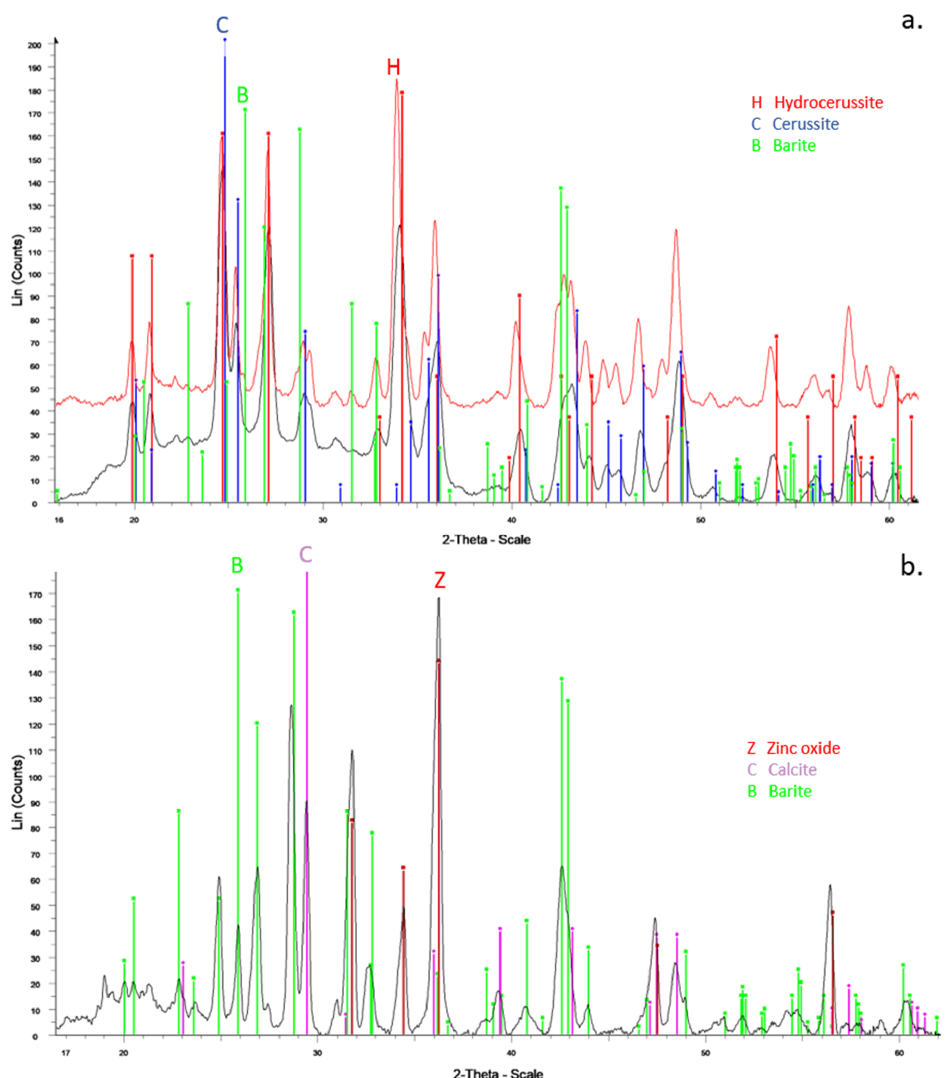
Figure 8. ( a ). XRD diagram shows the presence of hidrocerussite (red vertical lines), cerussite (blue vertical lines) and barite (green vertical lines) in CRIST07 (black spectra) and CRIST08 (red spectra) zones. ( b ). XRD diagram shows the presence of calcite (purple vertical lines), barite (green vertical lines) and zinc oxide (red vertical lines) in CRIST09 zone.